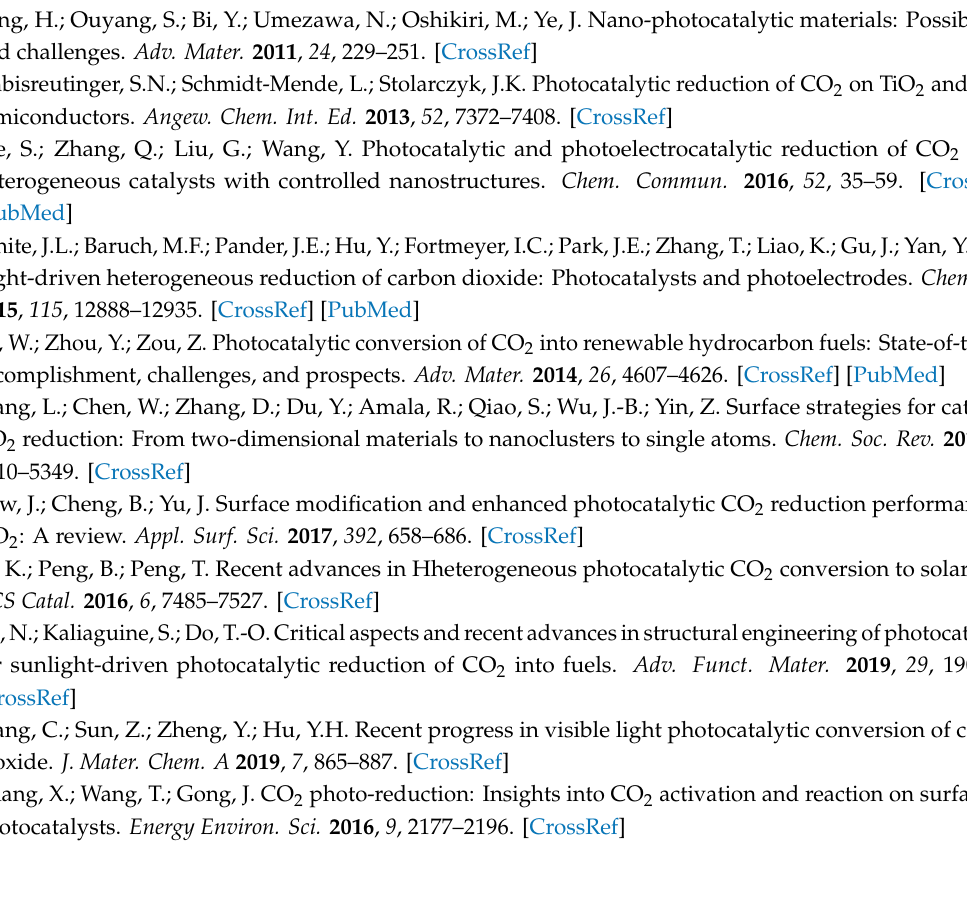
Figure S10: N 2 adsorption and desorption curves and BET surface areas of P25, TCPP@P25 and TCPP-M (M =